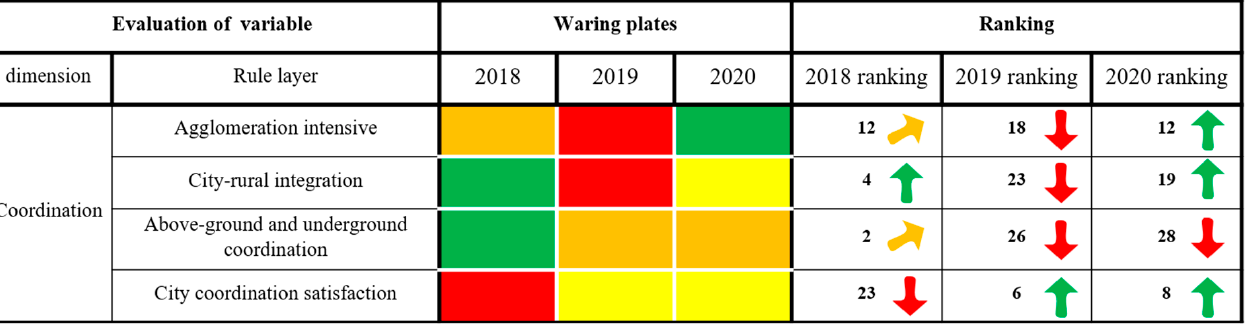
Figure 8. The results of the coordination dimension of city health examination and evaluation in Xining City.